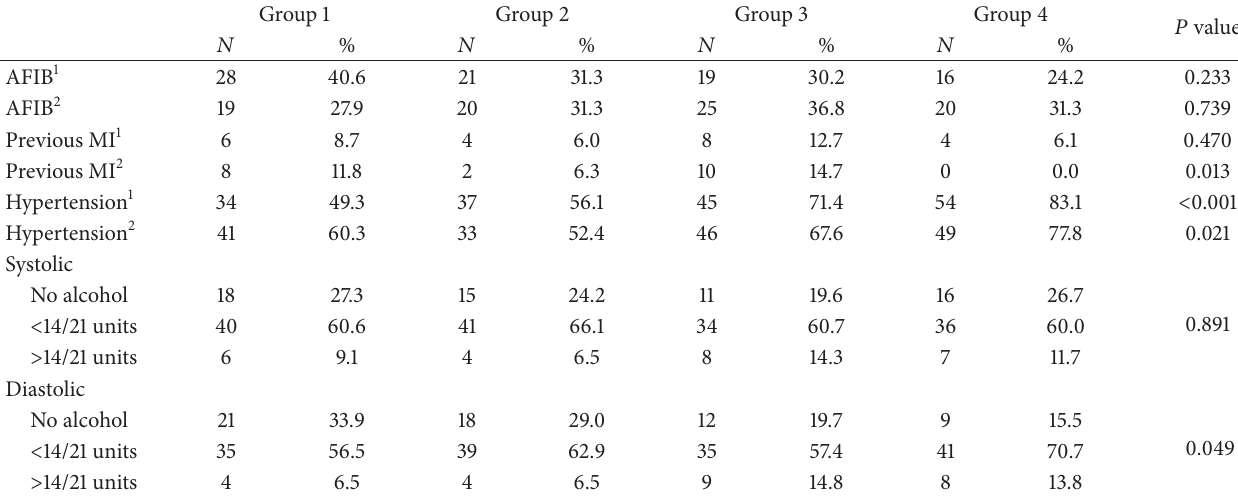
Figure 4: The association between mRS after 3 months representing long-term outcome, and the development in the systolic blood pressure groups within the first 12 hours after admission. The blood pressure group 2 has the lowest long-term outcome value (mRS = 1) compared to the other blood pressure groups. Table 3: Previous medical history and risk factors in the blood pressure